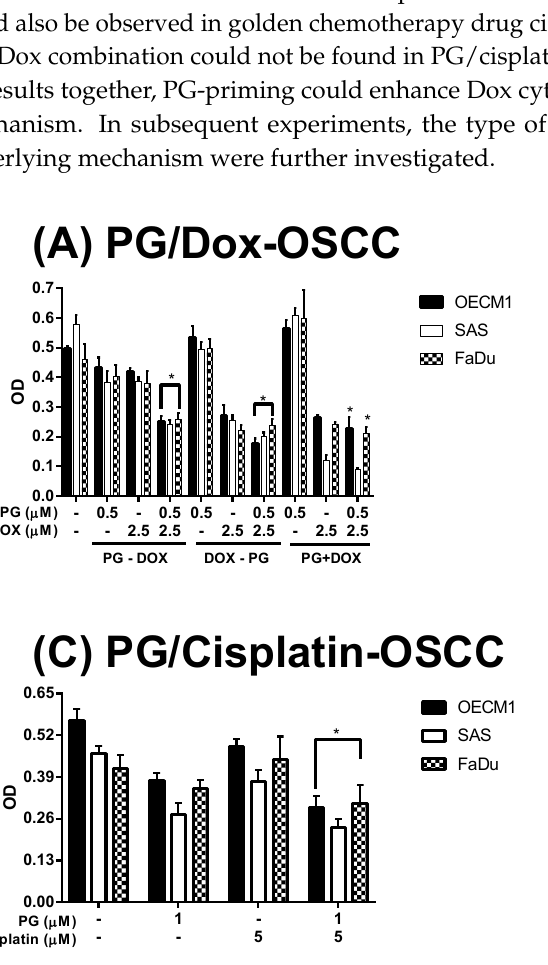
Figure 1. Alteration of cytotoxicity in sequential PG (prodigiosin)/Dox (doxorubicin) and PG/cisplatin combination in oral squamous cell carcinoma (OSCC) and BEAS-2b cells. ( A ) OSCC and ( B ) normal bronchus cells-BEAS-2b were treated with various schemes of PG and Dox, and ( C ) Cisplatin substituted Dox for 12 h and analyzed cell viability by 3-(4, 5-dimethylthiazol-2-yl)-2, 5-diphenyltetrazolium bromide (MTT) assay. The results were represented as mean ± SD from three individual experiments. * p < 0.05 as compared with Dox alone.